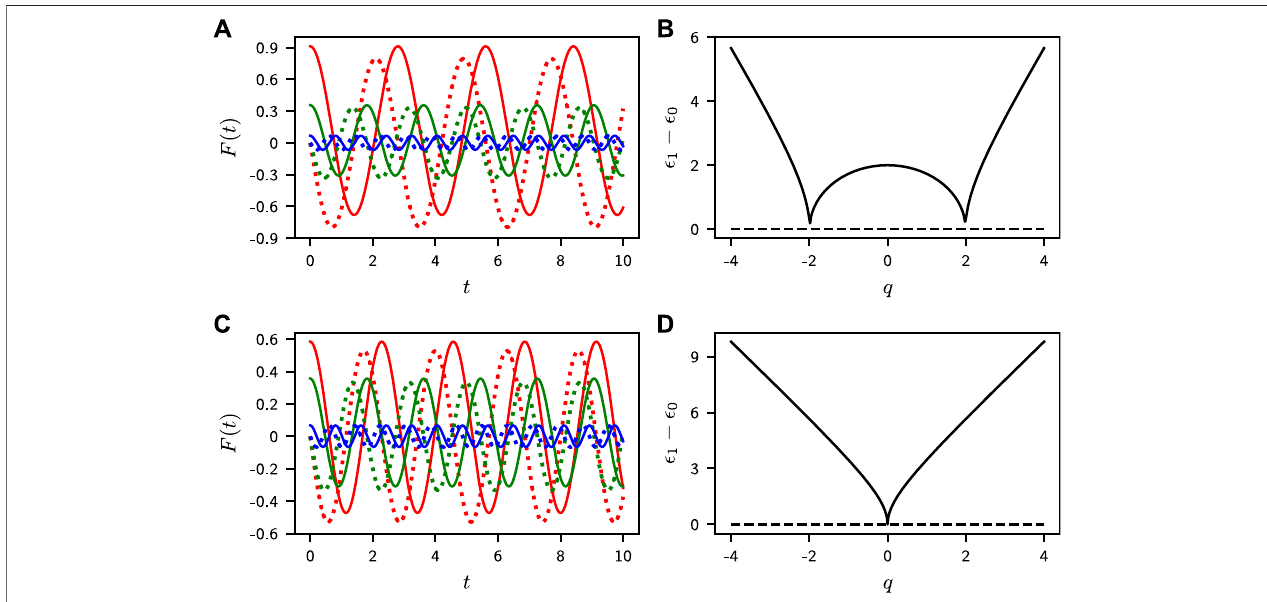
FIGURE 5 | F ( t ) for different q as a function of time t . The solid and dotted lines correspond to Re( F ) and Im( F ), respectively. The red, green, and blue lines correspondto q =2.5, q =3,and q =5,respectively,forferromagneticinteraction (A) .Thered,green,andbluelinescorrespondto q =0.7, q =1,and q =3,respectively for antiferromagnetic interaction (C) . The energy gap between ground and the fi rst excited state ϵ 1 − ϵ 0 as a function of q for ferromagnetic (B) and antiferromagnetic interactions (D) , at system size N = 5000.